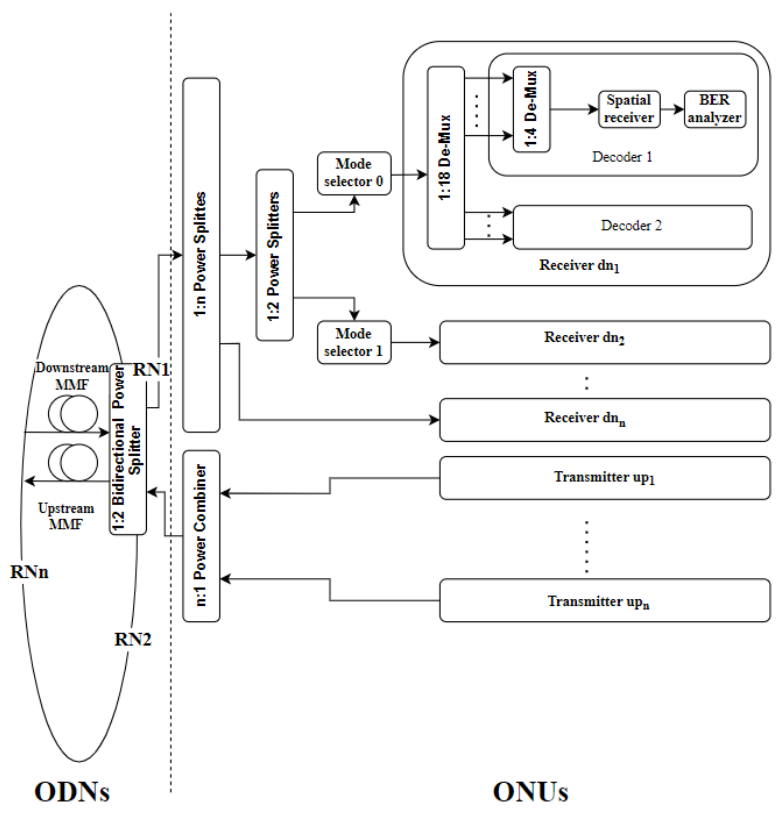
Figure 5. Proposed design of bidirectional MDM-PON system incorporating MWZCC OCDMA code of receiver section.